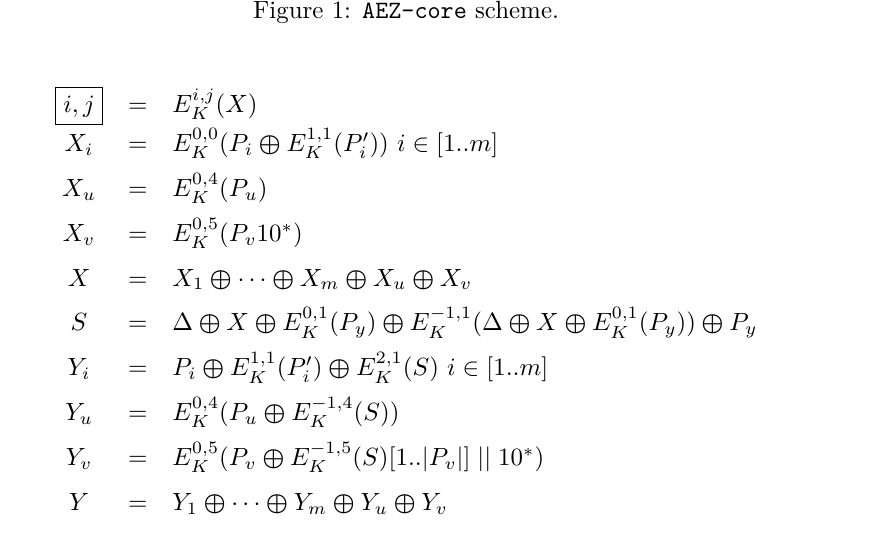
Figure 1: AEZ-core